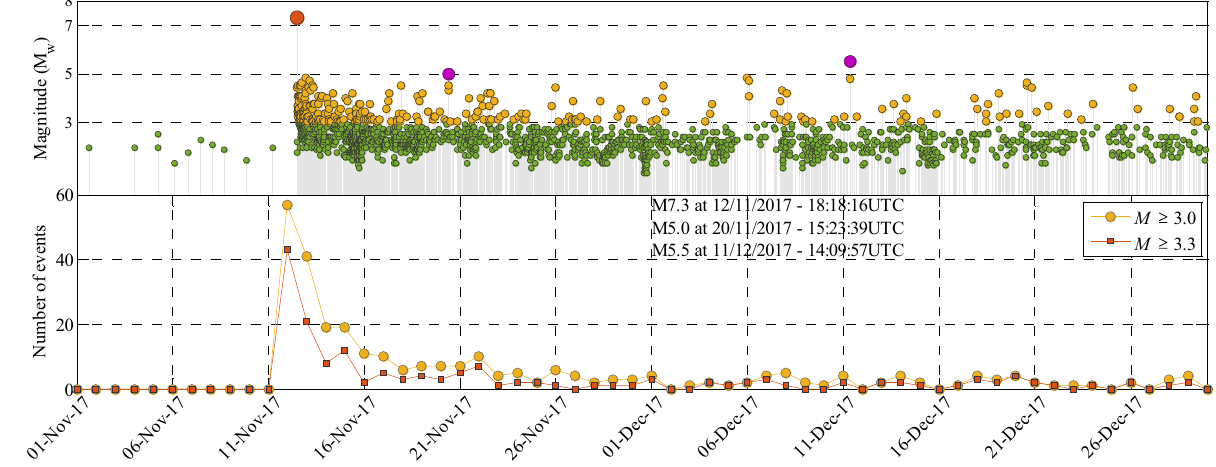
Figure 2. Magnitude vs. time (top) and the number of events with M ≥ 3.0 and M ≥ 3.3 (bottom) occurred within a 24-h interval starting from 6:00 UTC of each day from 01/11/2017 ( T o ) until 30/12/1017 including the Azgeleh MS of M w 7.3 within phase 1 of the complex Kermanshah 2017–2019 seismic